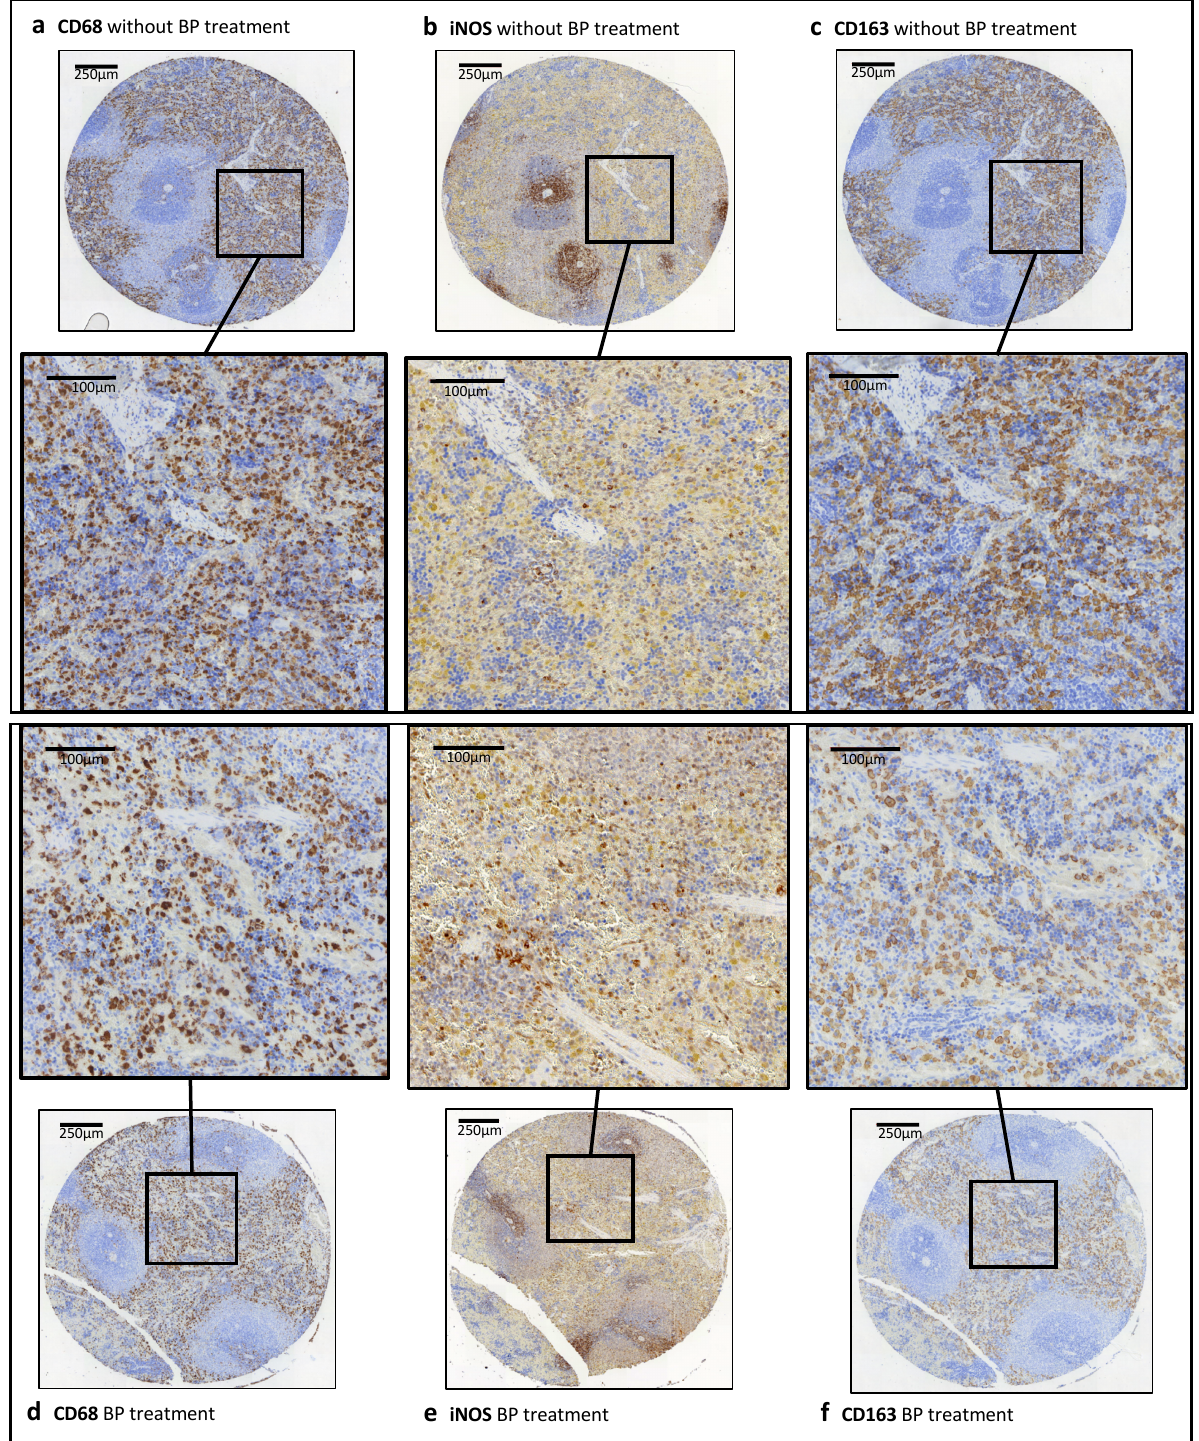
Figure 6. Comparison of the stainings from spleen tissue without and with BP treatment. Expression of the macrophage markers CD68, CD163 and iNOS distribution in a TMA core of spleen tissue of rats without ( a – c ) and with ( d – f ) BP treatment are shown, and their associated